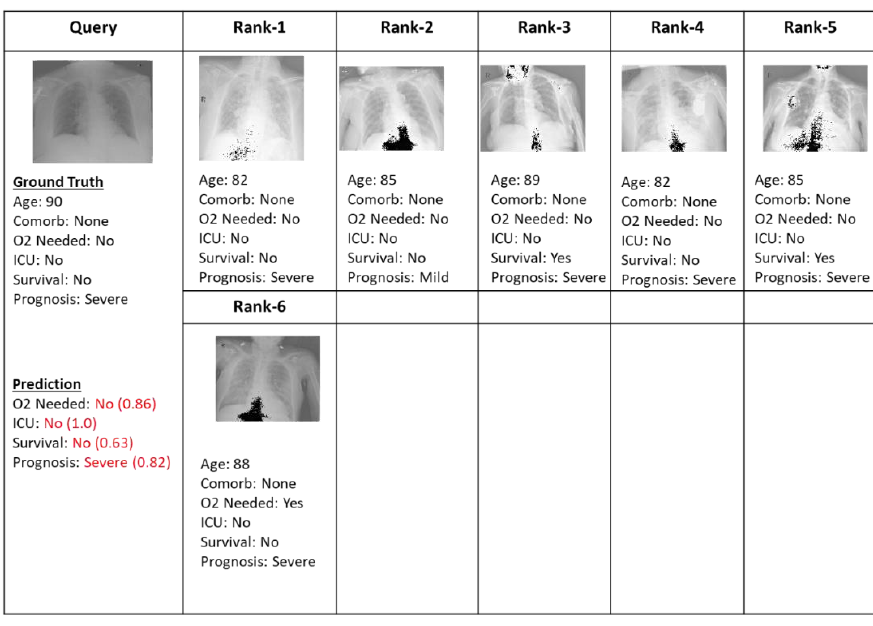
Figure 11. Top 7 relevant cases retrieved for the query case (Patient age = 90 years).